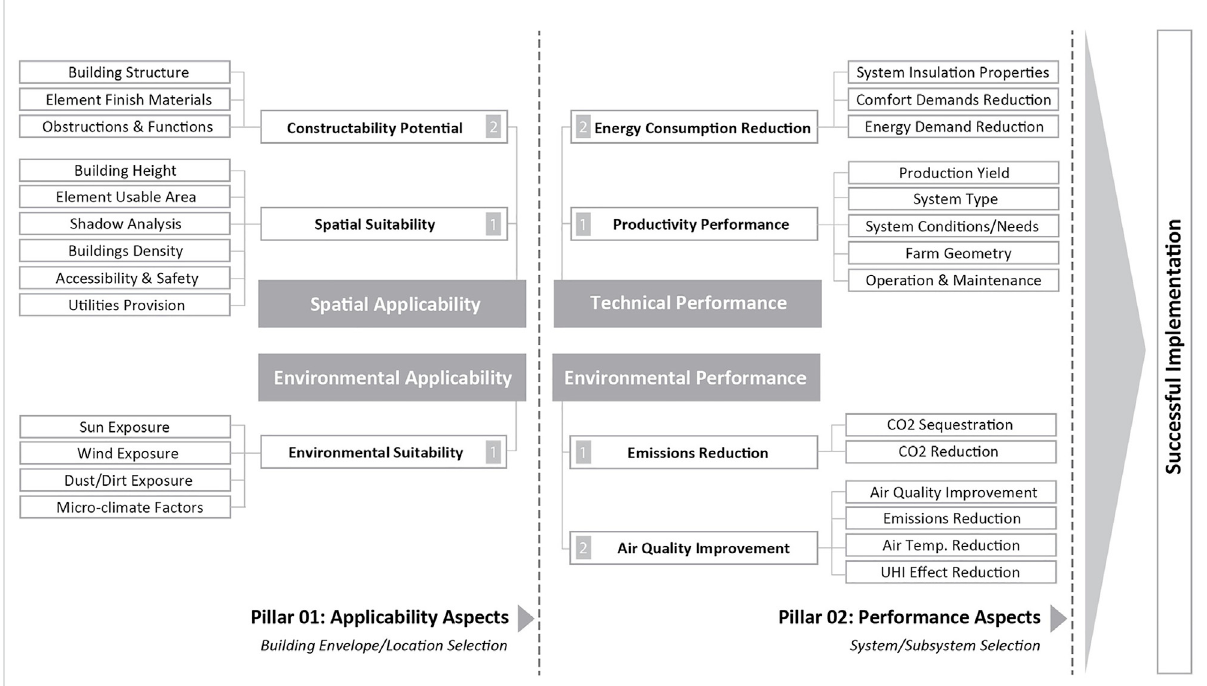
FIGURE 11 A comprehensive frameworkof implementation aspectscompiled from assessed studies and reports and grouped into two pillars: applicability aspects that de fi ne the suitability of systems ’ implementation on a speci fi c building envelope and location, and performance aspects that guide the selection of the most promising systems for implementation. For each category, subcategories were formulated and the detailed parameters outlined. The framework core is structured based on several studies (Perini et al., 2011; Ackerman, 2012; ADB, 2014; DEPI, 2014; Attoye et